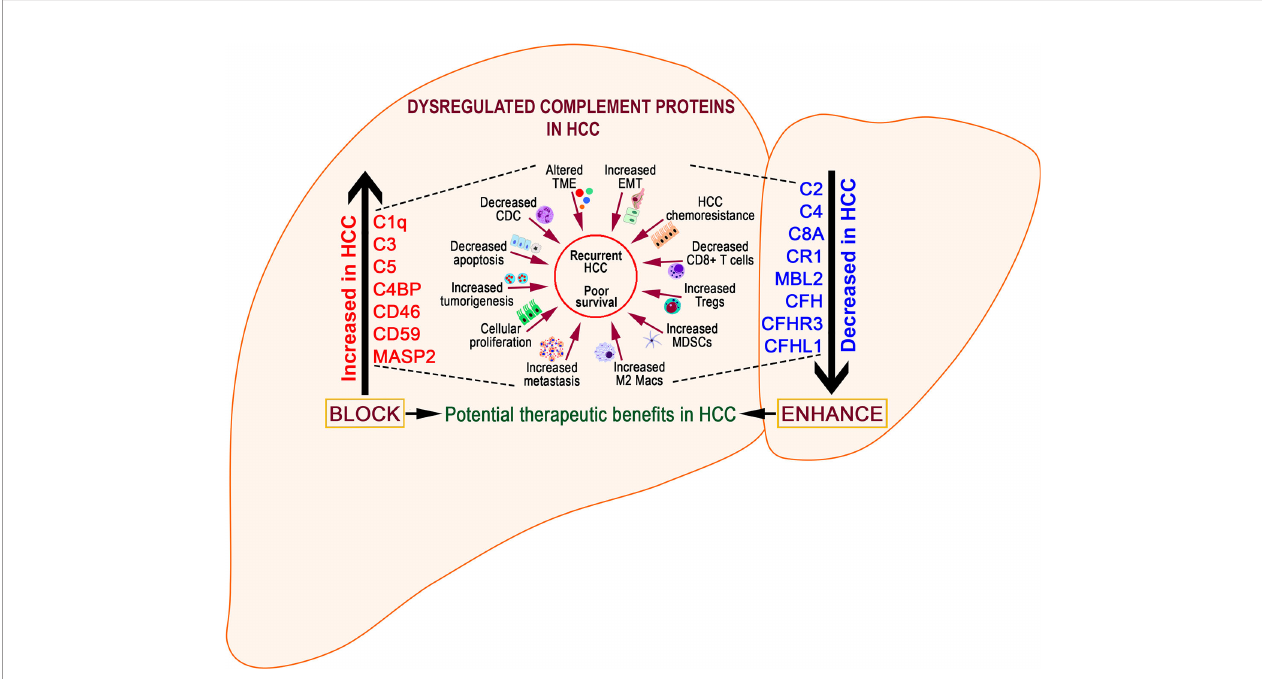
FIGURE 3 | Dysregulated expressions of complement components orchestrate the pathobiology of hepatocellular carcinoma. Breakdown of the tightly controlled activation and regulatory component signals of the complement system results in dysregulation of the normal homeostatic cellular processes within the liver microenvironment. Increased levels of C1q, C3, C5, C4BP, CD46, CD59, and MASP2 and decreased levels of C2, C4, C8A, CR1, MBL2, CFH, CFHR3, and CFHL1 with potential immunoregulatory functions contribute to increased cell proliferation, metastasis, EMT, altered immune cell functions, etc. resulting in recurrent episodes and/or poor overall or disease-free survival in patients with HCC. Images from Motifolio drawing toolkit software (http://motifolio.com) were used for rendering the fi